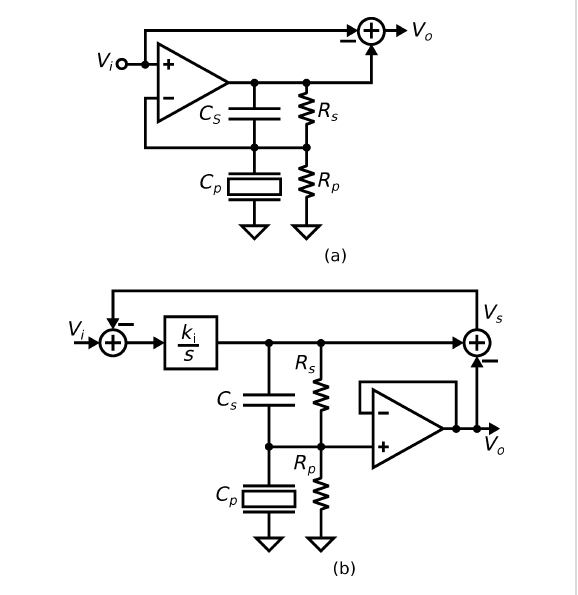
Figure 3: The instrumentation circuits. (a) The voltage driven arrange- ment. (b) The charge driven arrangement.